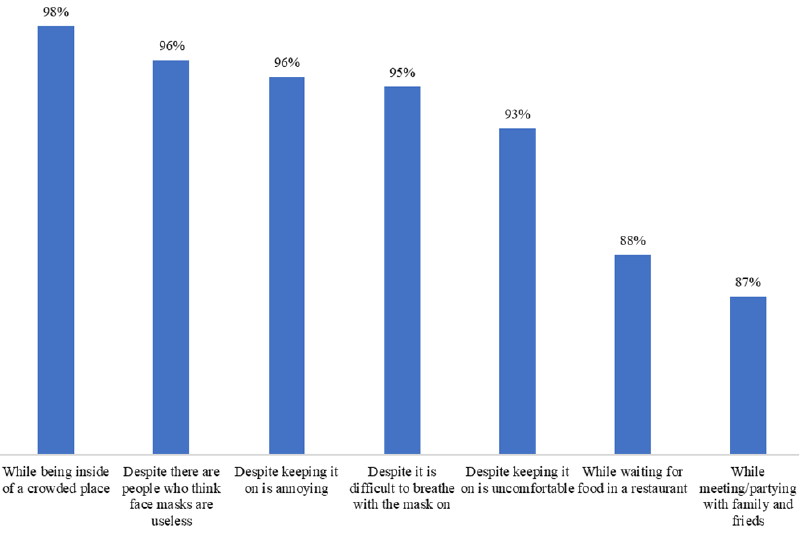
Figure 5. Self-efficacy (high or very high) of wearing face masks in patients with diabetes (n =